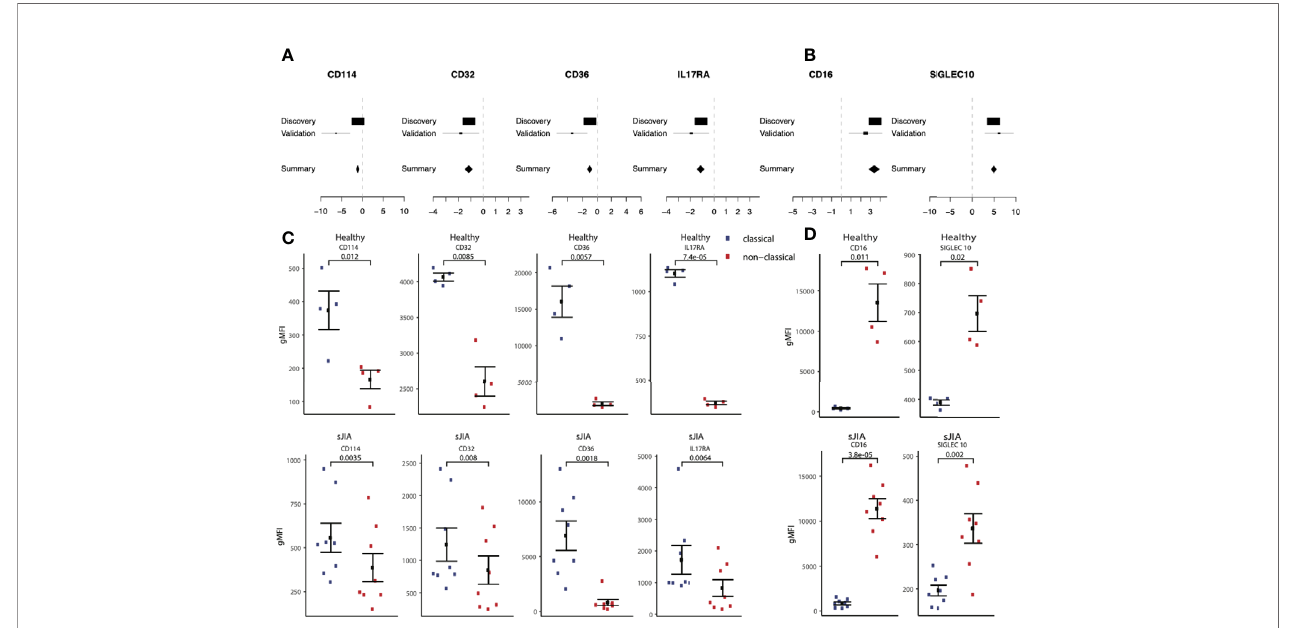
FIGURE 7 | Monocyte signature genes distinguish monocyte subsets by fl ow-cytometry: (A) mRNA expression effect sizes comparing classical vs. non-classical subsets in both discovery and validation cohorts for each marker associated with classical monocytes (lower effect sizes values indicate higher expression in classical monocytes). (C) Same as (A) but for markers associated with non-classical monocytes (higher effect size values indicate higher expression in non-classical monocytes). (C) Monocyte subsets were manually gated using FlowJo software. Data shown are geometric mean fl uorescene intensity (gmean) in both healthy (top row) and sJIA patients (bottom row). Comparisons made using T-test unpaired unless speci fi ed for markers associated with classical monocytes. (D) Same as (cs) for markers associated with non-classical